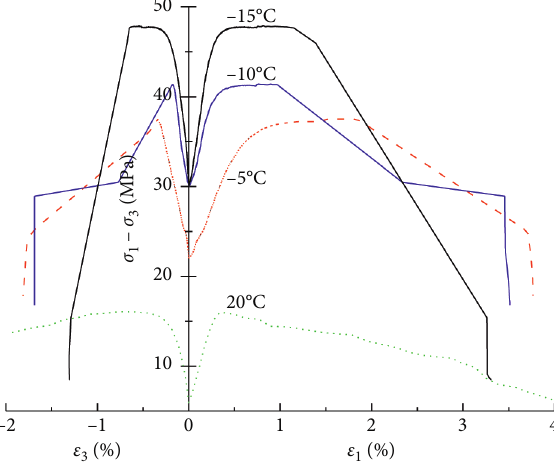
Figure 7: Stress-strain curves of lateral unloading sandstone at different temperatures ( σ 0